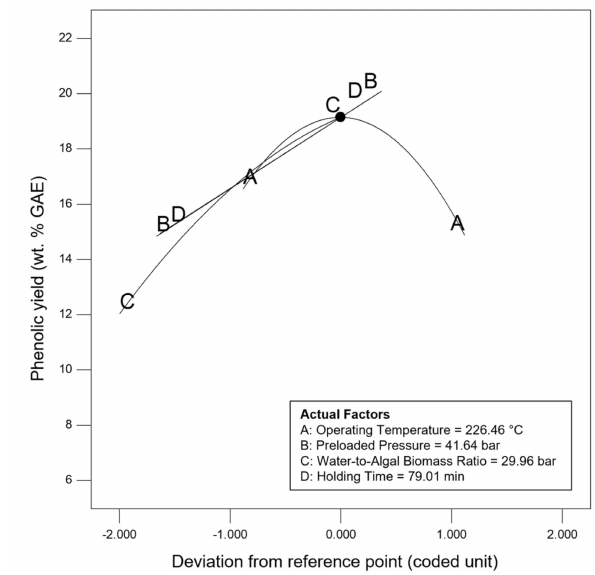
Figure 7. Perturbation plot for response, phenolic yield.